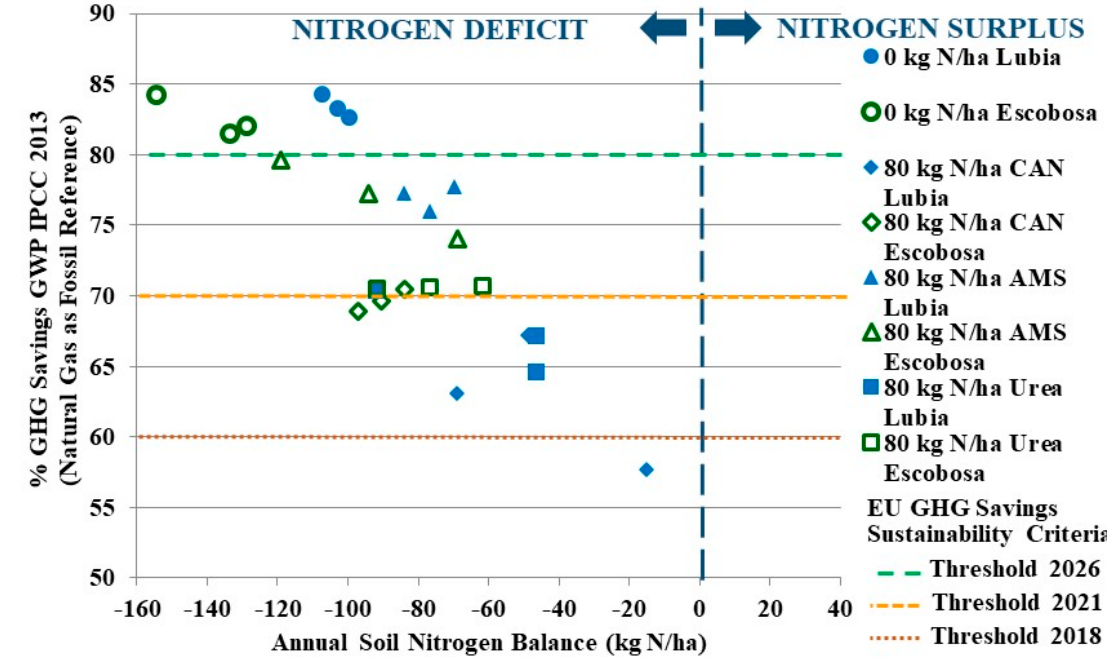
Figure 3. Relationship between the GHG savings obtained when producing bioenergy with rye energy crops grown under different fertilizer regimes with respect to natural gas in relation to the soil nitrogen balances (calculated with the GWP IPCC 2013 100 years method). GWP: Global warming potential, IPCC: Intergovernmental panel on climate change, CAN: calcium ammonium nitrate, AMS: ammonium sulphate, EU GHG: European Union greenhouse gases. Regression equation: y = − 0.0019x + 0.5731.